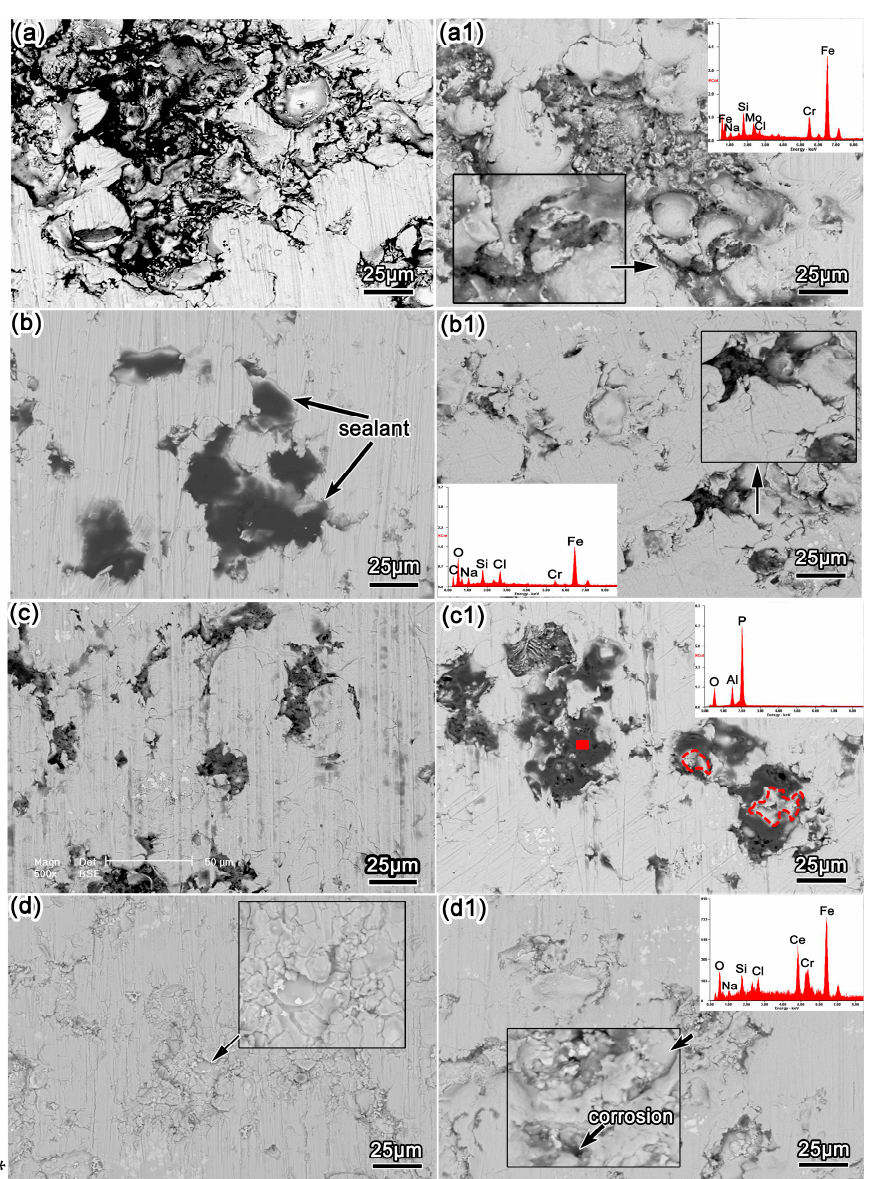
Figure 5. SEM morphologies of ( a , a1 ) as-sprayed AMC, ( b , b1 ) SAS coating, ( c , c1 ) APS coating and ( d , d1 ) CSS coating ( a – d ) before and ( a1 – d1 ) after erosion–corrosion tests for 12 h by 3.5 wt.% NaCl solution containing 2 wt.%